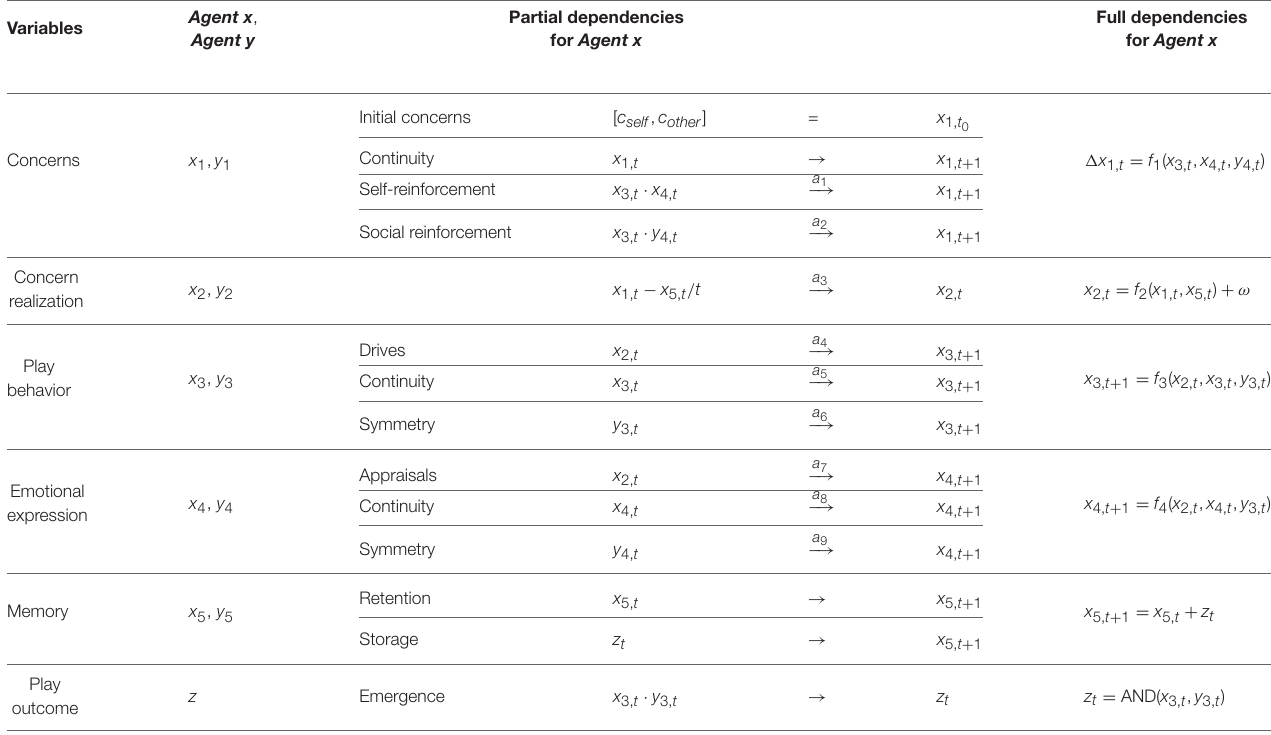
TABLE 1 | A simplified technical summary listing the coupled equations of Socio-emotional Concern Dynamics (SECONDS) between Agent x and Agent y , described by individual variables x 1 − 5 and y 1 − 5 , respectively, and joint variable z